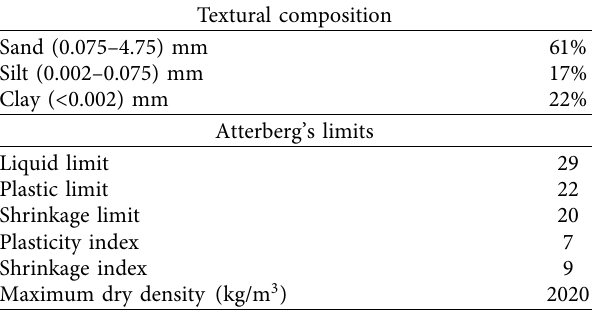
Table 1: Properties of soil used for